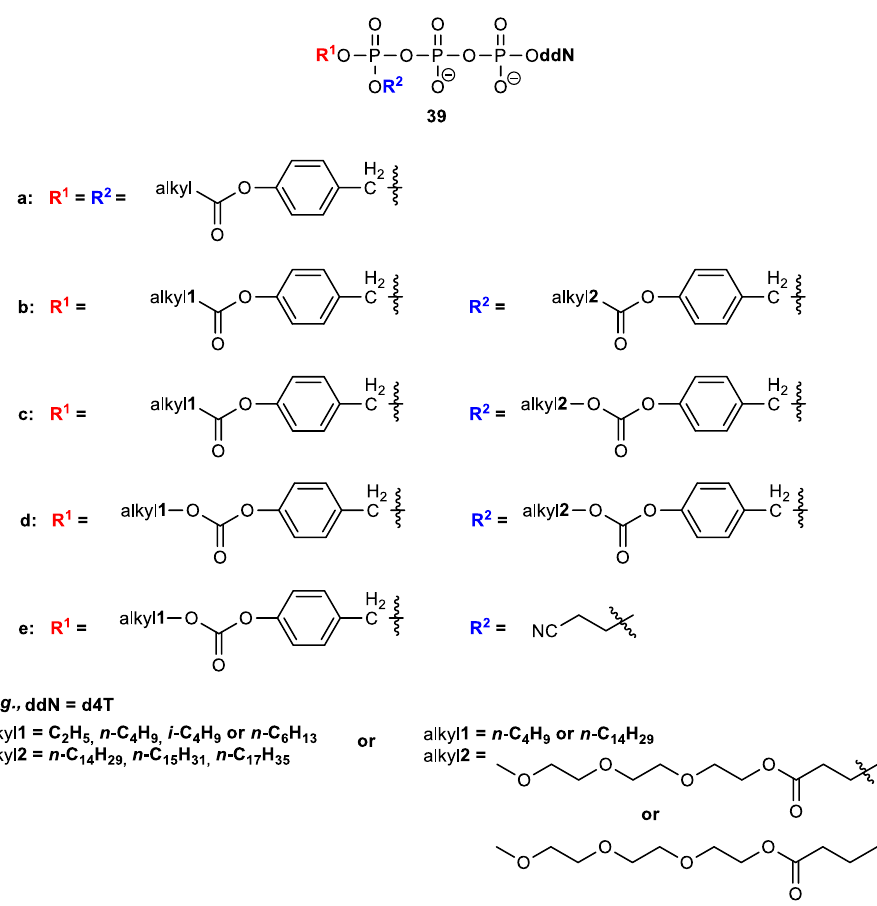
Figure 8. Examples of general structures of Tri PPP ro-nucleotides ( 39a – e ) synthesized by the Meier group [113,117,119].